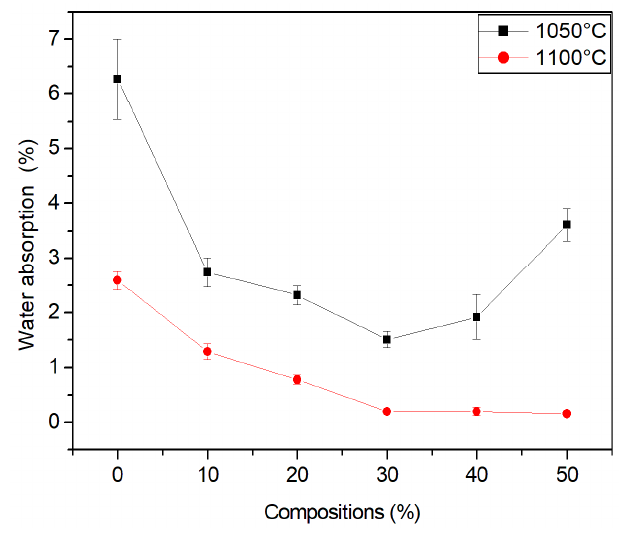
Figure 10. Water absorption of the ceramic material.